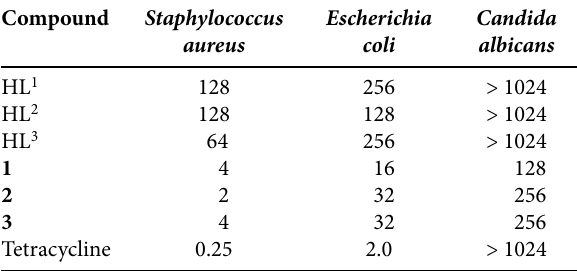
Table 4. MIC values (μg/mL) for the antimicrobial activities of the tested compounds Compound